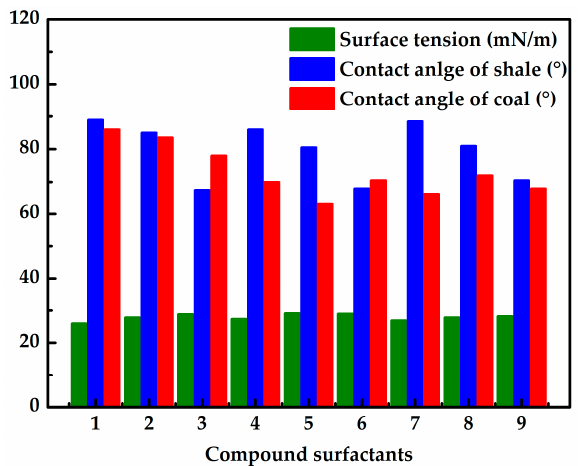
Figure 6. Effect of the optimized compound surfactants on surface tension and contact angle of shale or coal samples.